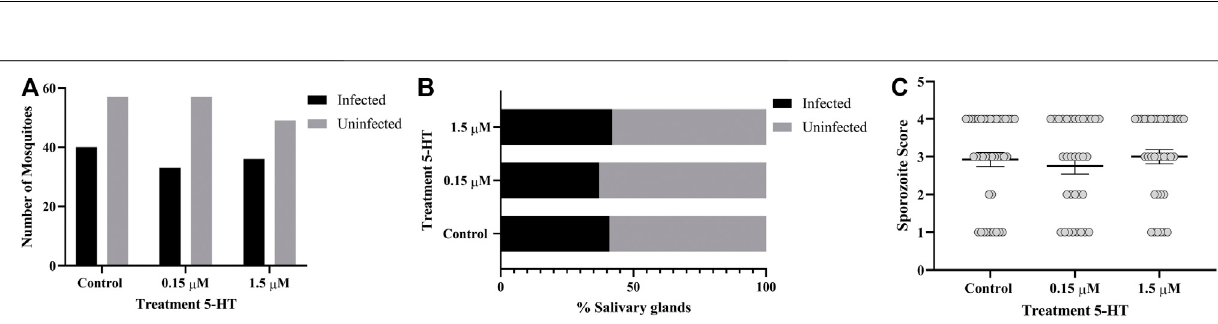
FIGURE 6 | P. yoelii yoelii 17XNL oocyst infection in A. stephensi following priming for 3 days with 5-HT or water (control) soaked cotton balls. (A) Numbers of infectedanduninfectedmosquitoesbytreatment withsigni fi cantdifferencesnotedamongpairs,and (B) datafrom (A) shownaspercentagesofuninfectedandinfected mosquitoes in each group. N = 6; Fisher ’ s exact test ( α = 0.05), **control vs. 1.5 μ M p = 0.0021. (C) Mean P. y. yoelii 17XNL midgut oocysts. N = 6; 1-way ANOVA ( α = 0.05), p = 0.0410, *control vs. 0.15 µM, p = 0.0178, *control vs. 1.5 µM, p = 0.0490.